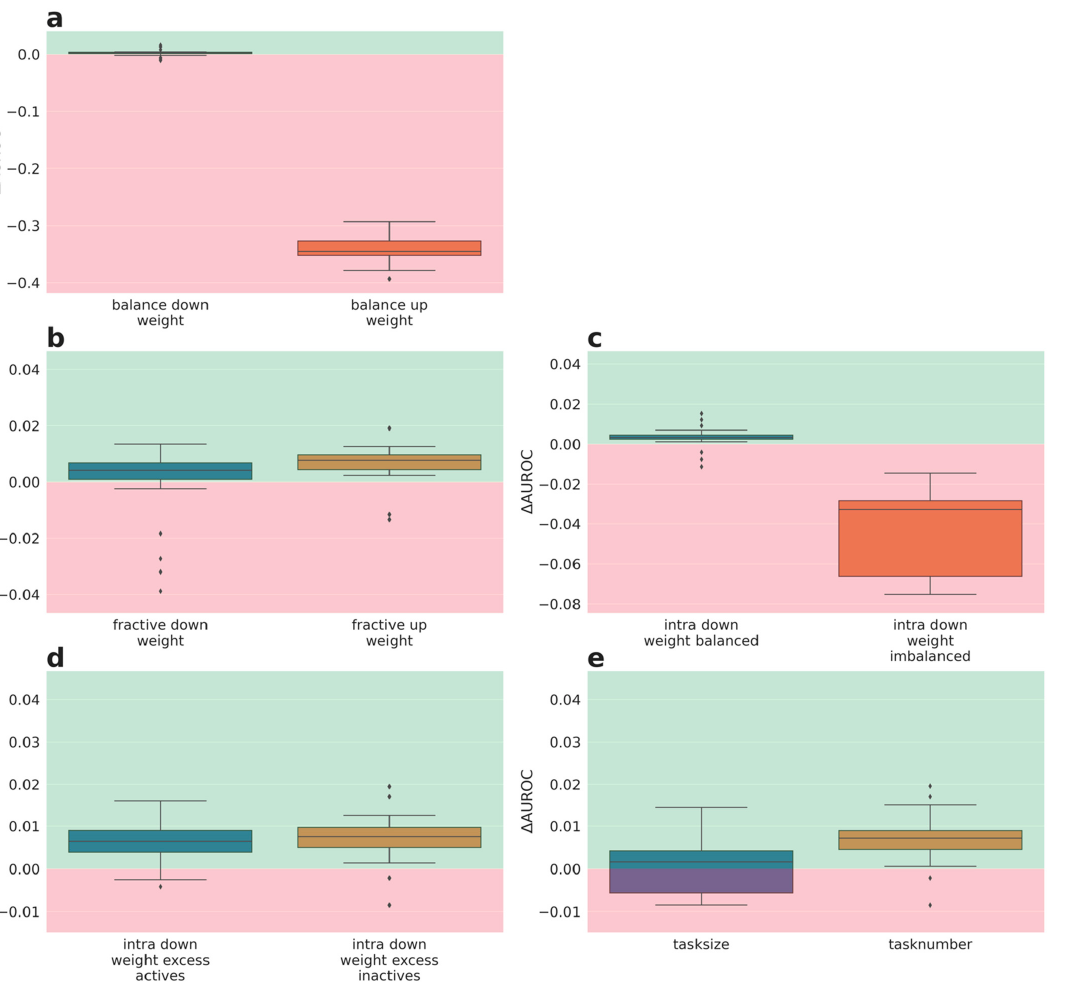
Figure 4. Phase III results averaged over 5 partners and 5 folds for lower quartile tasks performances (AUROC): ( a ) global weighting wrt. label balance, left: down-weighting balanced tasks, right: down-weight imbalanced tasks, ( b ) global weighting wrt. fraction actives, left: down-weighting excess of actives, right: down-weight excess of inactives, ( c ) intra assay weighting wrt. label balance, left: down-weighting balanced tasks, right: down-weight imbalanced tasks, ( d ) intra assay weighting wrt. fraction actives, left: down-weighting excess of actives, right: down-weight excess of inactives, ( e ) left: weight set wrt. number of datapoints, right: based on 1/task_number. Green: better performance than baseline (1), red: worse performance than baseline.